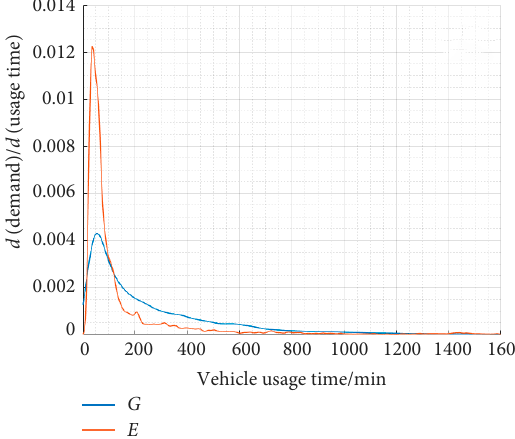
Figure 8: Kernel function fitting curve for 𝐸 & 𝐺 .